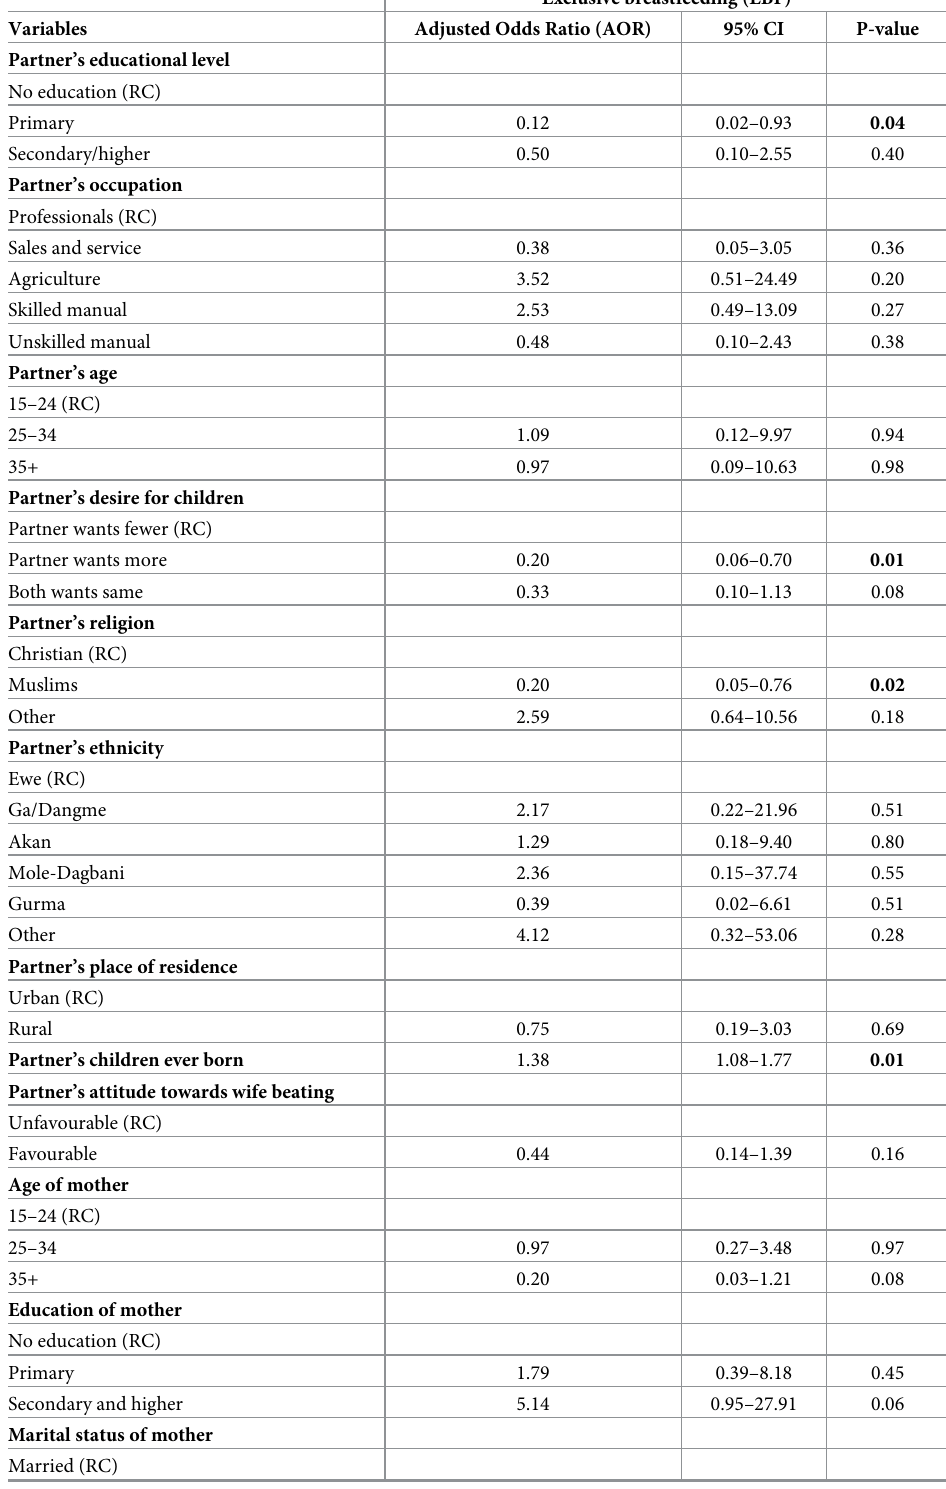
Table 3. Binary logistic regression showing the factors associated with exclusive